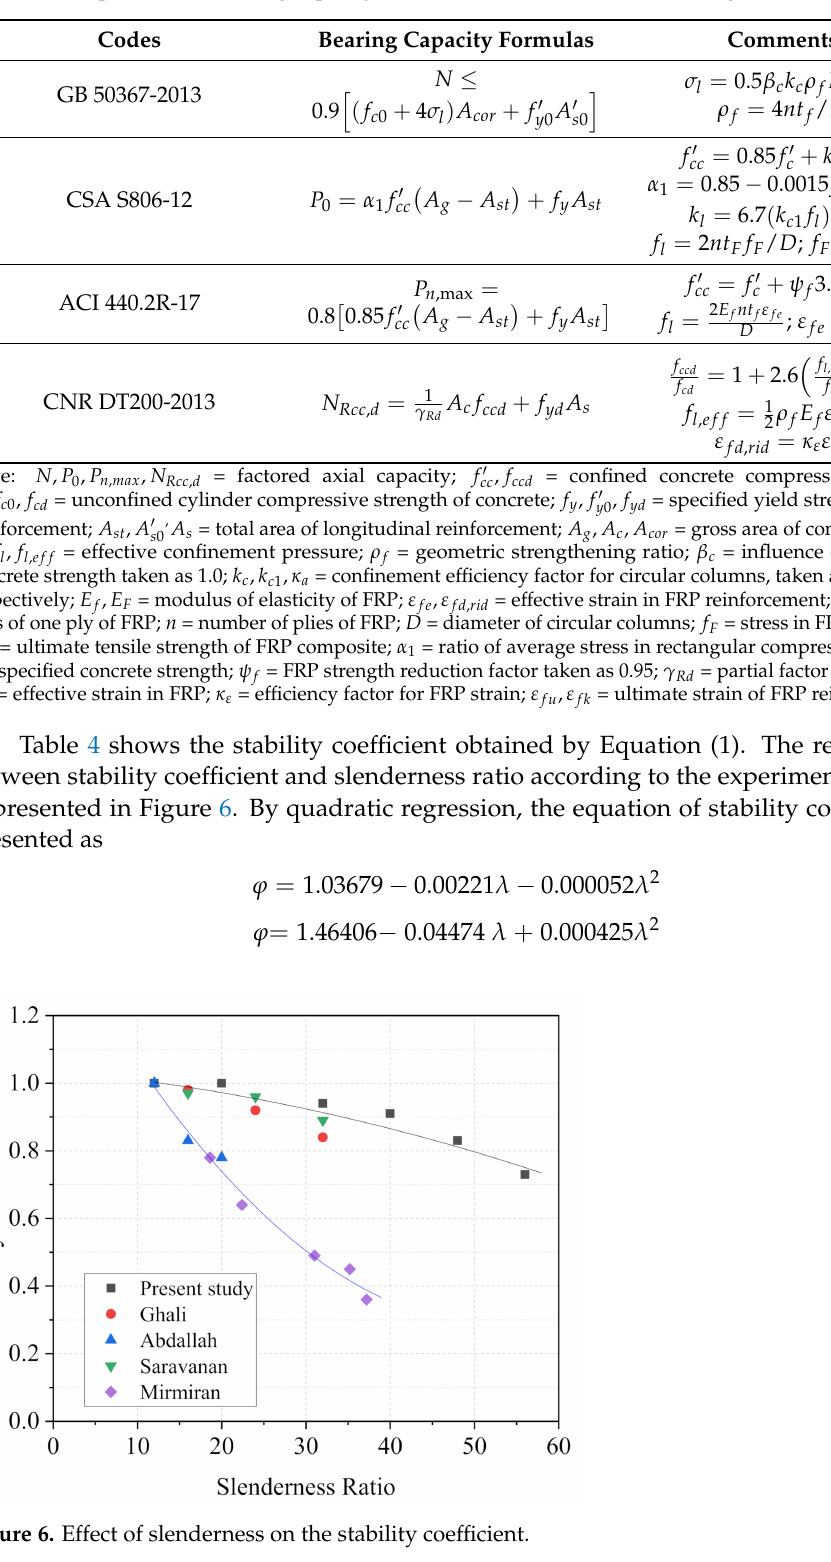
Table 5. Comparisons of bearing capacity formulas in concrete structure design codes.